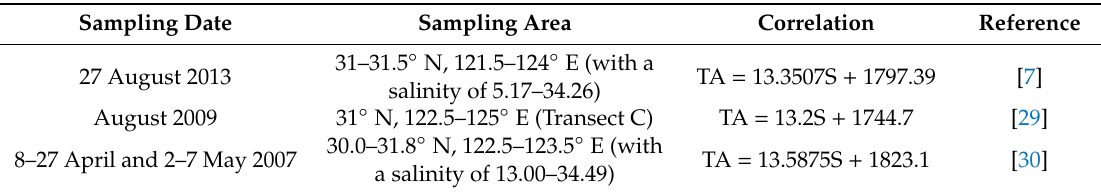
Table 1. Summary of correlation between total alkalinity (TA, µ mol kg − 1 ) and